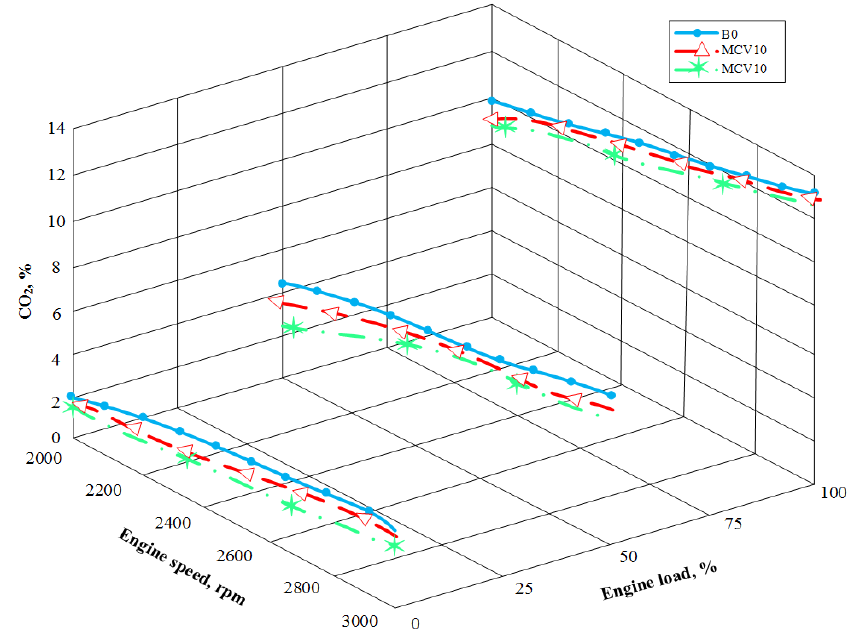
Fig. 7. CO 2 emissions of MCV biodiesel blends at different loads/speeds.